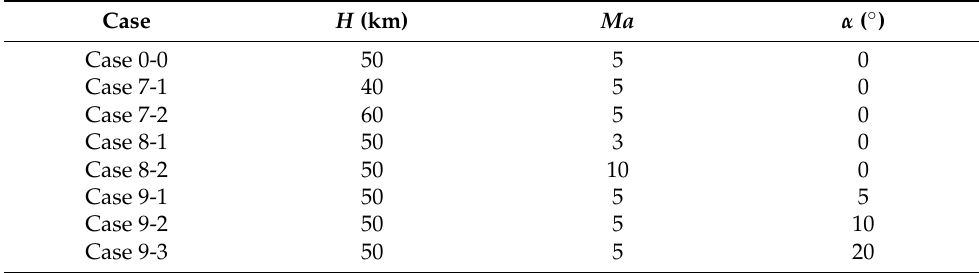
Table 5. Calculation cases of flight parameters changing.